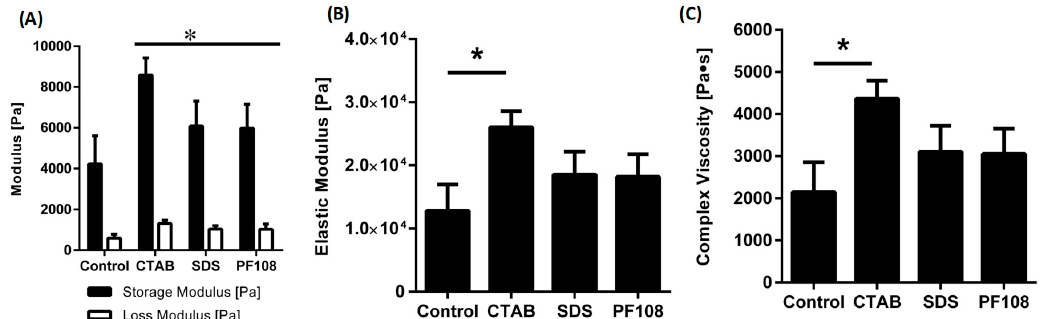
Figure 3. Rheological properties of different surfactant/SWCNT-based hydrogels. * indicates statistically significant difference ( p < 0.05) in comparison with controls. Only the CTAB samples appeared to have significantly increased values for elastic modulus and complex viscosity in comparison with controls, as shown in panels ( B ) and ( C ). All SWCNT-el samples depicted a significant increase in Storage and Loss Moduli, in comparison with controls ( A ).